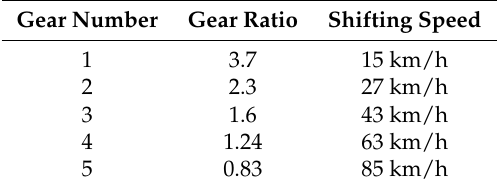
Table 3. Gear ratios and shifting